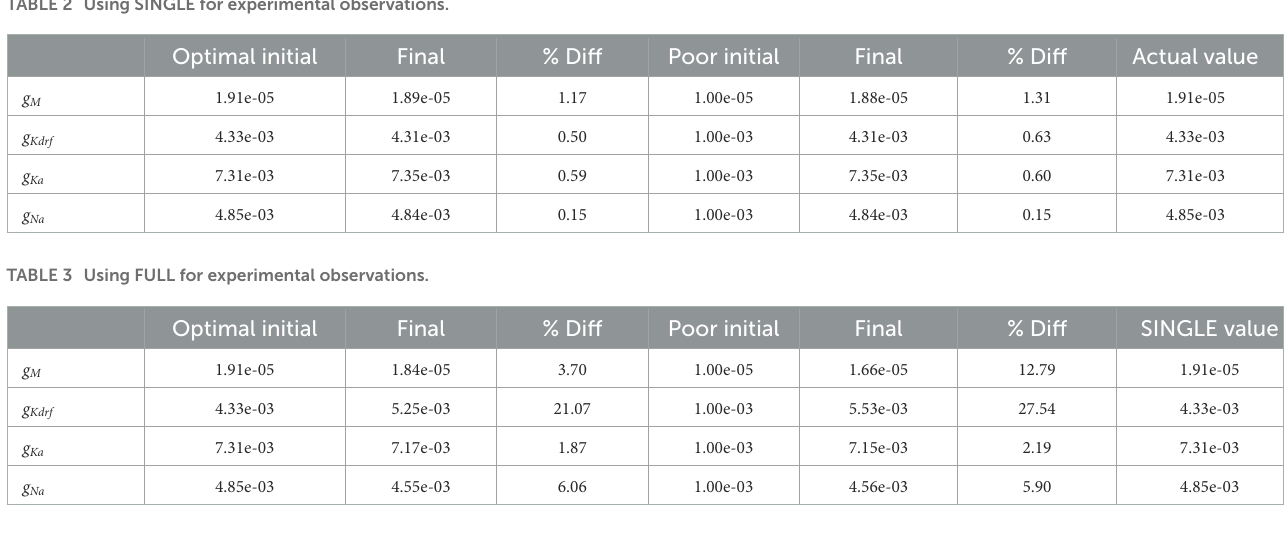
FIGURE9 RAUKF input protocol. (A) Noisy input protocol applied to mathematical model to obtain parameter estimates. It is a noisy step current ( σ mean step of 30, 60, 90, 0, 30, 60, 90 pA , for 196 ms each repeated four times beginning with 250 ms of noisy current. (B) Gray trace is observation − − − used in filter, black trace is the real membrane potential, FULL. Red and green traces are RAUKF model estimated behavior initialized with parameters determined with optimal and poor initial estimates respectively processed observing the FULL model. Blue trace is model SINGLE, parameters determined by BluePyOpt.